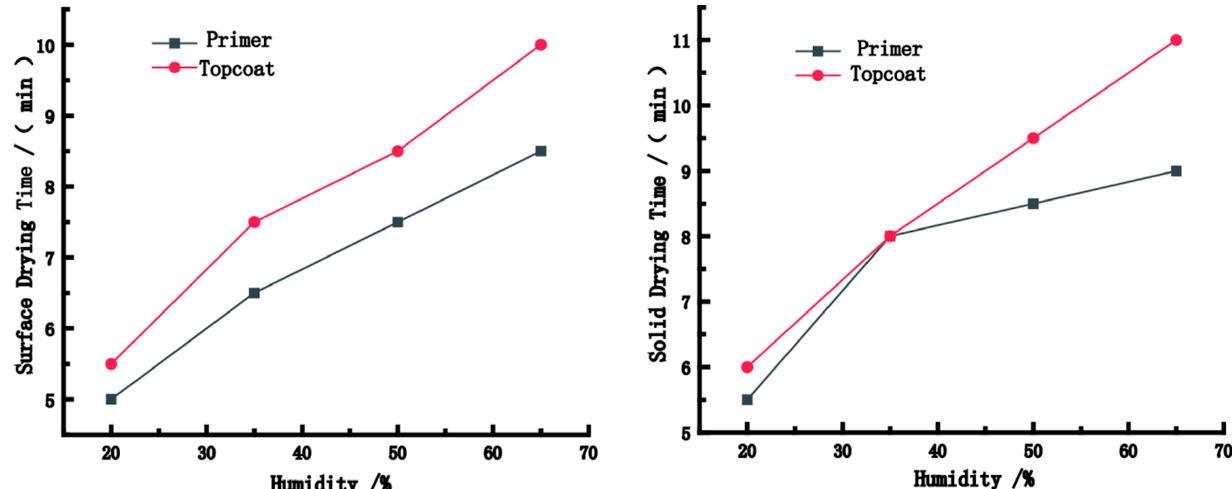
Figure 3. The surface and solid drying time of the paint films under different humidity values.